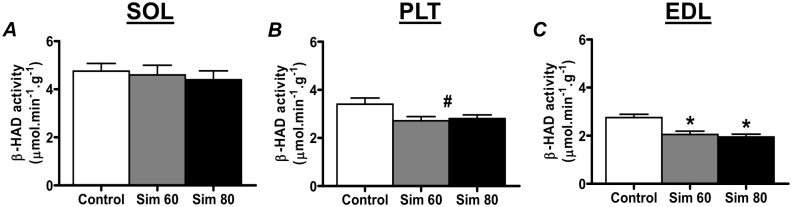
The effect of simvastatin treatment on β-HAD activity.Rats were treated with vehicle (Control) or simvastatin at 60 (Sim 60) and 80 mg.kg-1.day-1 (Sim 80) for 14 days. Muscles were collected and subjected to enzyme activity analysis as described in the Methods. *—significantly different from Control (P < 0.05). #—strong trend for main effect (P = 0.05) compared to Control. Mean ± SEM. n = 8/group. One way ANOVA with Newman-Keul’s post-hoc test.